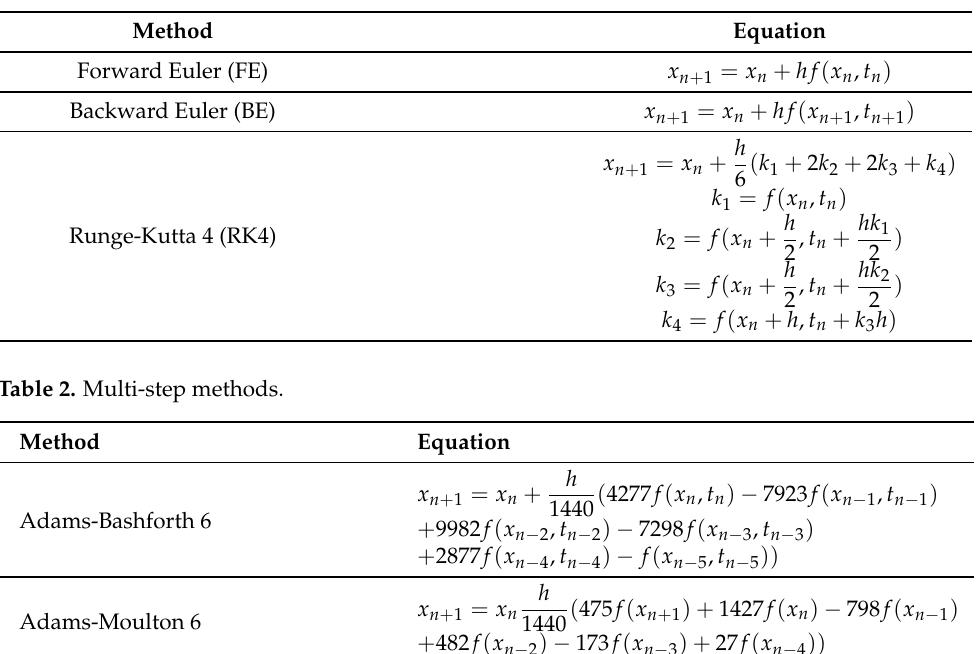
Table 1. One-step methods.